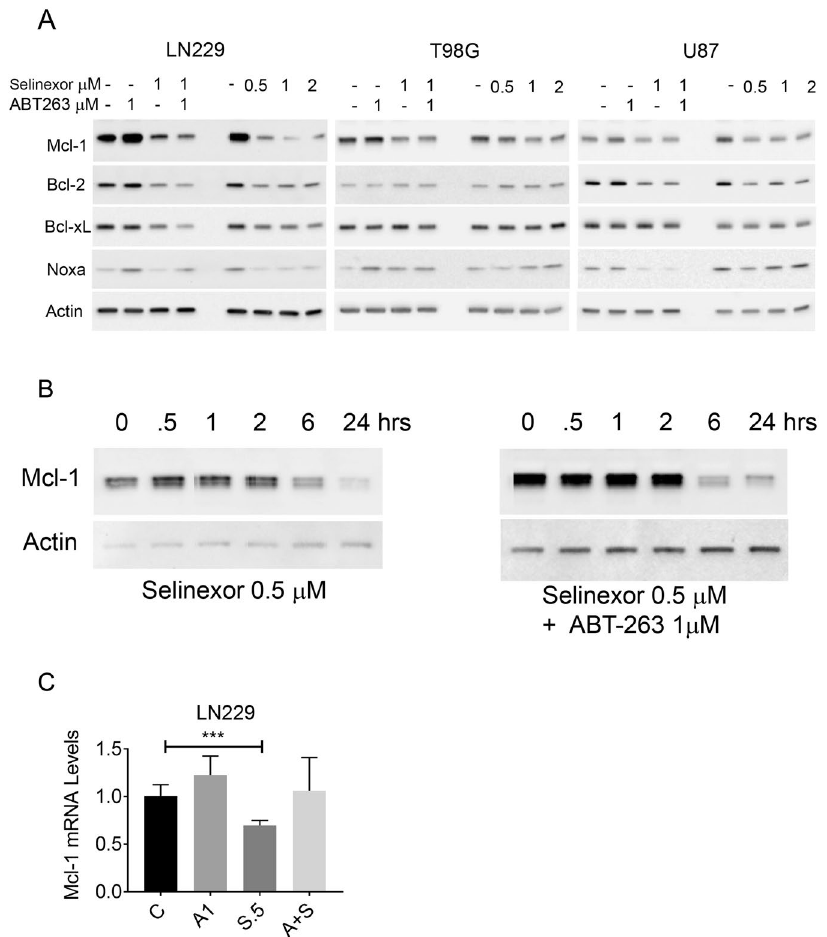
Figure 4. Inhibition of XPO1 by selinexor regulates the expression of anti- and pro-apoptotic Bcl-2 family member proteins. ( A ) LN229, T98G and U87 GBM cells were treated with ABT263, selinexor or the combination. Alternatively, cells were treated with increasing concentrations of selinexor for 24 h. Thereafter, whole cell protein lysates were collected and analyzed by conventional western blotting for the expression of Mcl-1, Bcl-2, Bcl-xL, Noxa and Actin. All concentrations are in μ M. ( B ) LN229 GBM cells were treated with selinexor or the combination treatment of ABT263 + selinexor for the indicated time points (time course experiment). Thereafter, whole cell protein lysates were prepared and analyzed for the expression of Mcl-1. Hrs: hours. ( C ) LN229 GBM cells were treated with vehicle, ABT263, selinexor or the combination treatment. After 6 h, RNA was harvested, reverse transcribed and subjected to real-time PCR analysis for